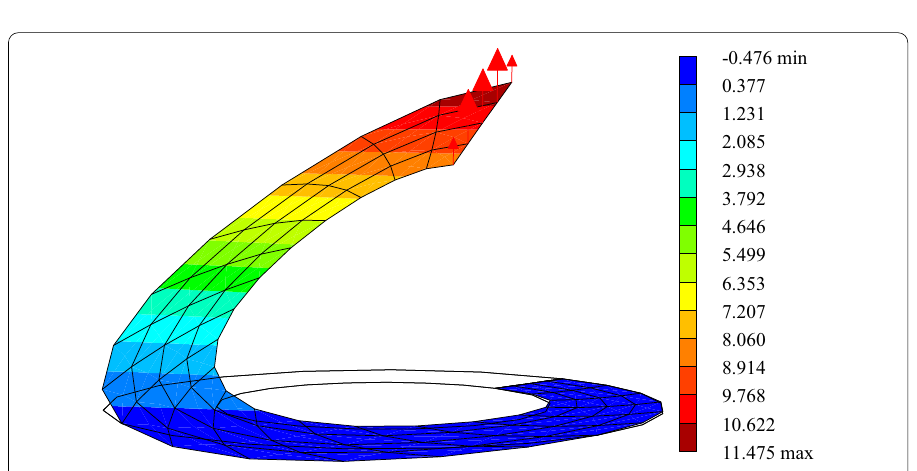
Fig. 36 Annular plate: vertical displacement and deformed plate using a distorted 4 × 20 mesh for p = 1